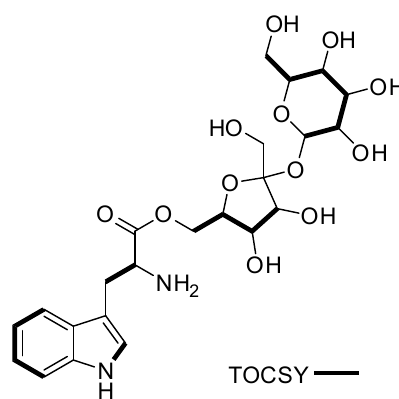
Figure 3. Key TOCSY (bold lines) correlations for compound 1 .